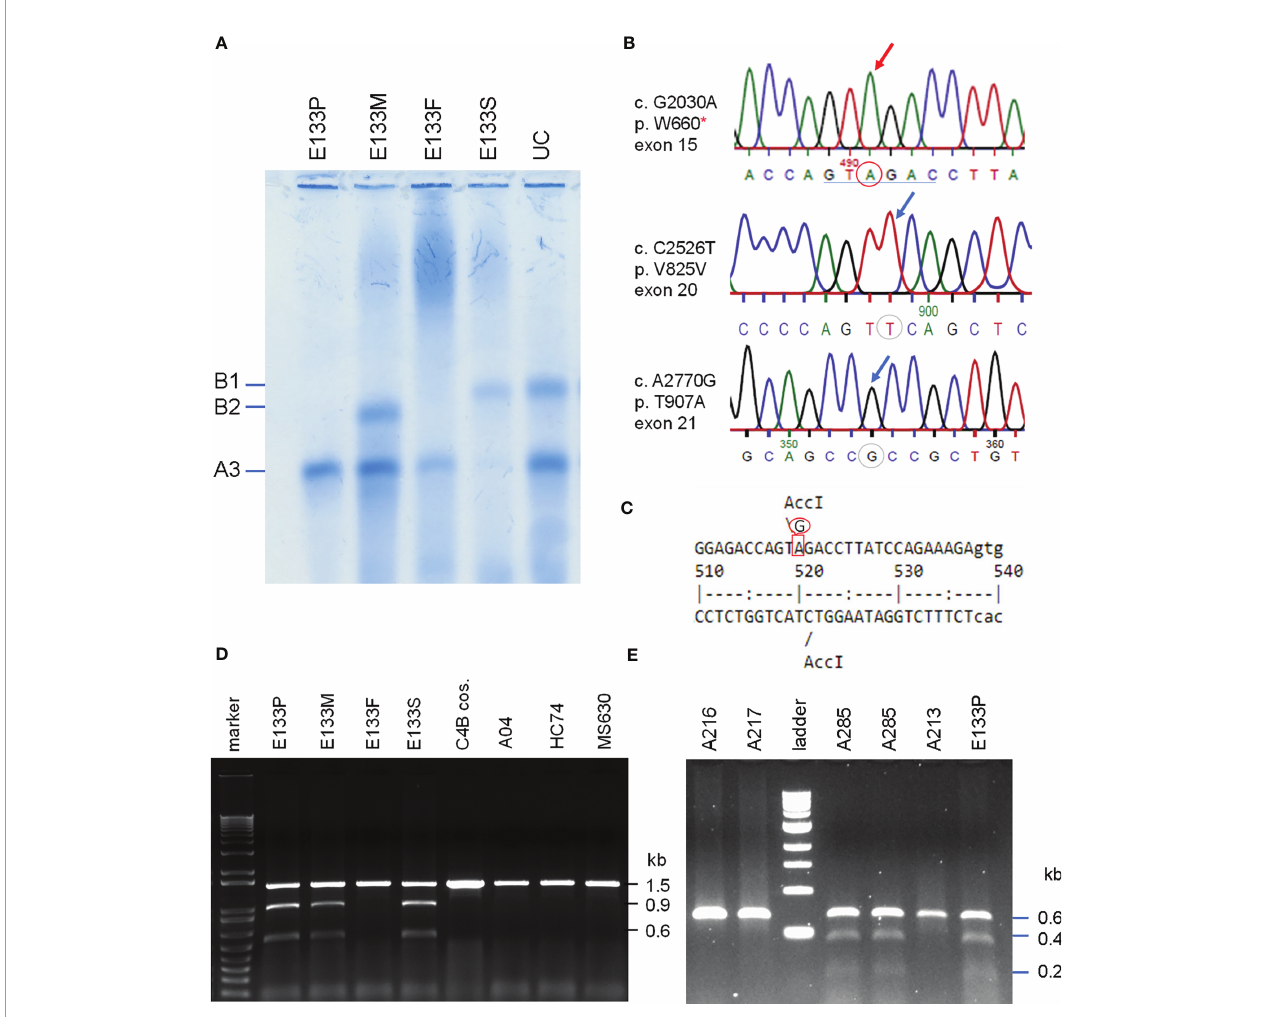
FIGURE 6 | Identi fi cation of the molecular defect leading to C4B de fi ciency in an Asian patient with anti-NMDA receptor encephalitis (E133P). (A) Immuno fi xation of EDTA-plasma for C4 protein of the E133 patient (P), parents (M and F), and step-brother (S) plus an unrelated individual (UC). (B) Genomic DNA sequences showing conversion of W660 codon TGG conversion to nonsense codon TAG (W660x, upper). Middle and lower panels show two additional sequence variations for V825V from exon 20 (no change in amino acid) and for T907A from exon 21. (C) Genomic sequence that caused W660x mutation was distinguishable by Acc I RFLP. (D) Analyses of the E133 family and control subjects. An 1.5 kb DNA fragment spanning between exon 14 to exon 18 from eight subjects were ampli fi ed by PCR, digested with restriction enzyme Acc I and resolved by agarose gel electrophoresis. The results revealed that the W660x mutation was also present in his mother (E133M) and his stepbrother (E133S). (E) An improved method to detect W660x using a 0.6 kb fragment from intron 14 to intron 16 for Acc I RFLP. Subject A285 was performed in duplicate to con fi rm the presence of W660x. The molecular weight marker was the kb-ladder. The GenBank accession number for the DNA fragment containing sequence with W660x from E133P is